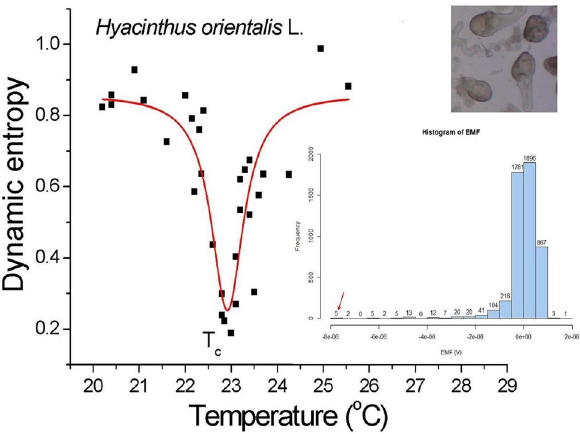
Figure 1. Dynamic entropy of hyacinth pollen tubes as a function of temperature and Inset fat-tailed electromotive force (EMF) histogram at the critical temperature T c . Entropy (ApEn) was calculated (each point separately) for the empirical EMF time series that was induced by the extracellular ionic fluxes of an isolated (intact) droplet that contained a collection of hyacinth pollen tubes. The determination coefficient for the experimental data that was re-calculated in R language (series of 5000-time points for each temperature at 30 different temperatures; sampling rate 4.1 Hz) fitted to the Lorentz resonance curve equaled R 2 = 0.7583 ( χ 2 = 0.014); half-width w 1/2 = 0.83(18) °C. The uncertainty of the individual temperature measurements equaled (cid:31) T = 0.1 °C. Note the extreme value of 5 × (− 8) × 10 −6 V ≈ 5 × (− 1) × 10 −5 V (i.e., more than two orders of magnitude greater than the noise level) in the inset (red arrow)—Photomicrograph of the elongating pollen tubes of Hyacinthus orientalis L.